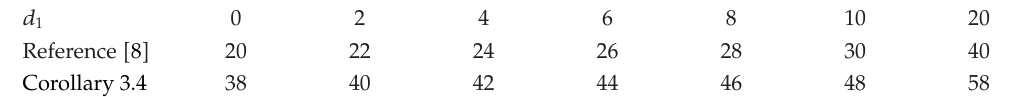
Table 2: Allowable upper bound of d 2 with given d 1 .